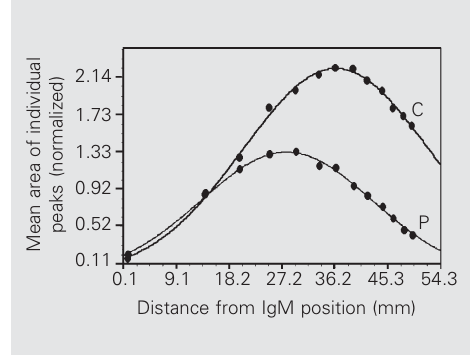
Figure 1. Representative densitometric tracing of vWF multimers in Western blots. Scan- ning was started at the IgM position (arrows, low molecular weight fractions) and run as indicated by the dashed lines in the direction of high molecular weight multimers (HMW). C and P are control plasma and patient plasma, respectively.